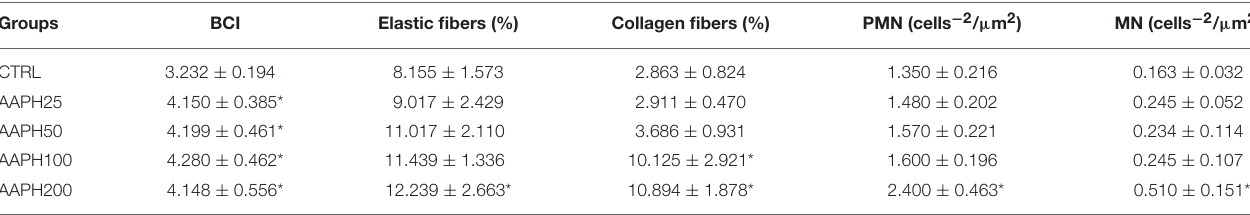
0.216 0.163 ± 0.202 0.245 ±